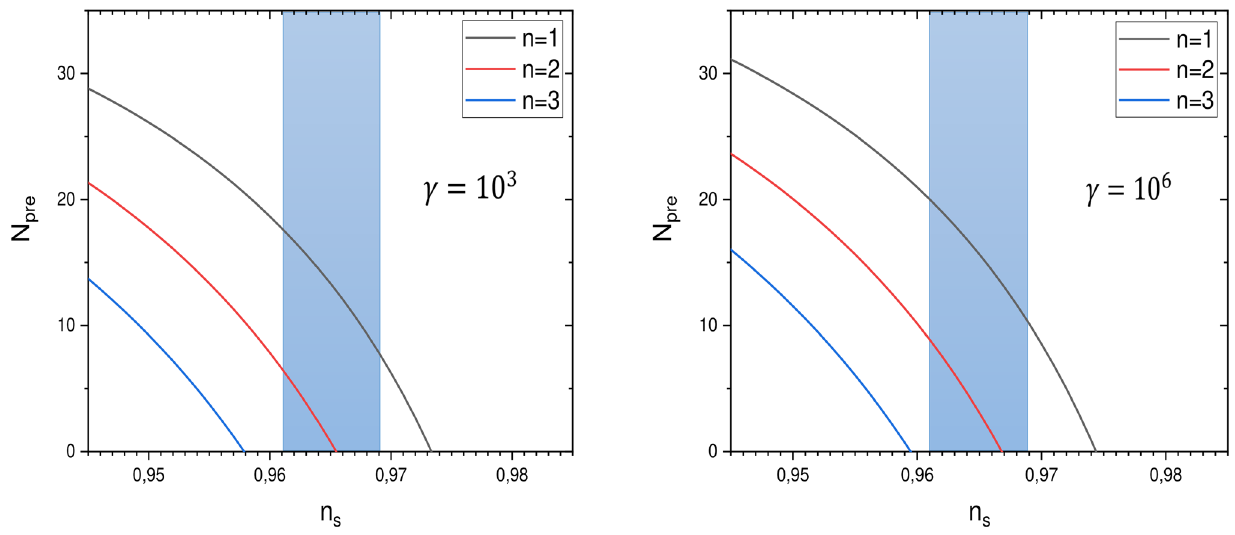
Fig. 2 The figure shows N pre the length of preheating, as a function of n s choosing the values of γ to be γ = 10 3 and γ = 10 6 for power-law potential with an inverse monomial coupling. Here, the vertical light Fig. 3 The variation of the density spectra of GWs as a function of N pre . For different values of gravity wave energy density Ω g w, 0 h